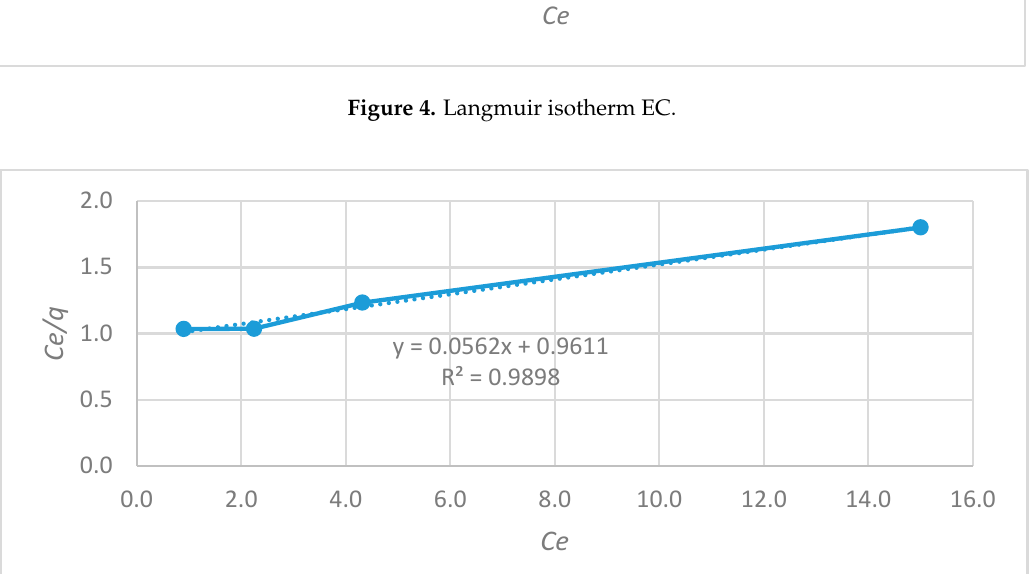
Figure 5. Langmuir isotherms (EC + Fe).